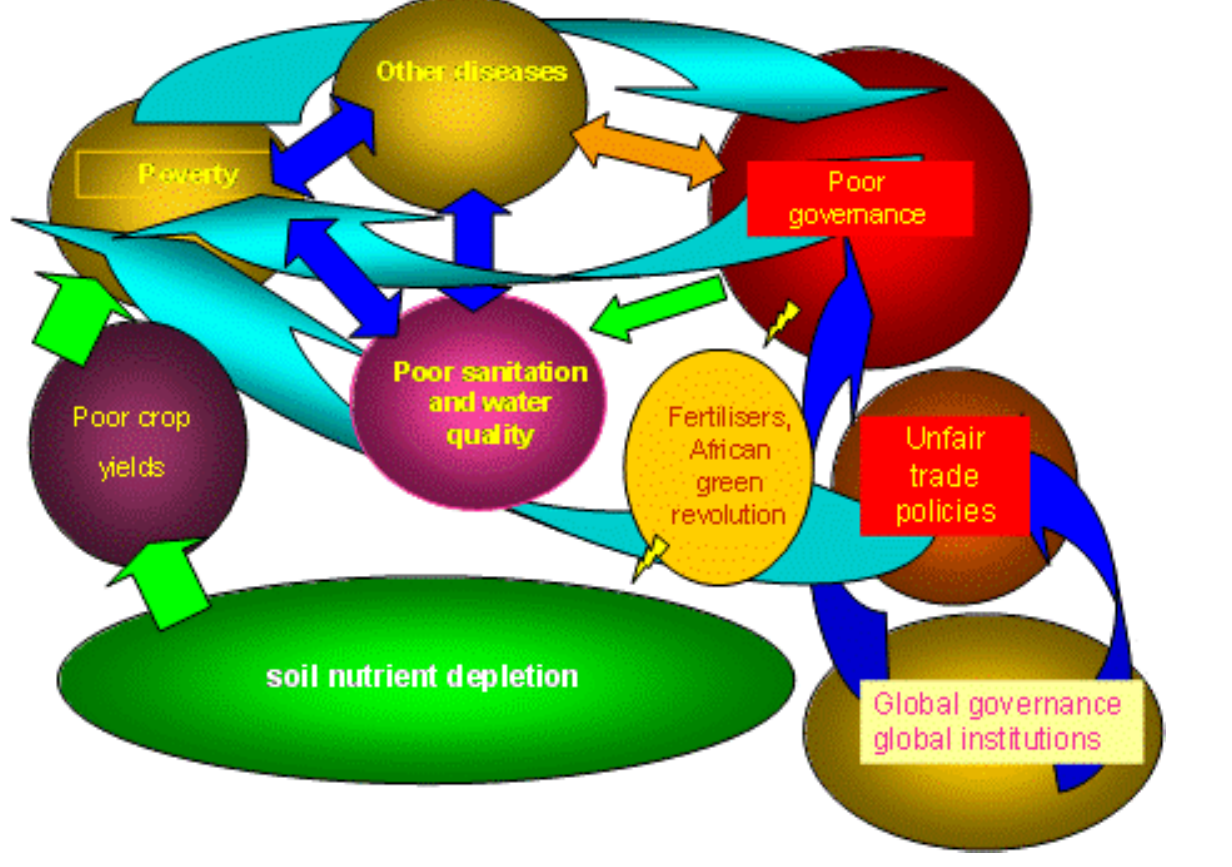
Fig. 1. A complex, interlinked network of factors operate to perpetuate poverty in much of the developing world, including sub-Saharan Africa. Literally dozens of economic, political, and social factors can be identified as contributing to a causal web that effectively serves to lock in poverty, poor governance, and undernutrition. Many of these factors are bi-directional, such as the relationship between poor governance, chronic disease, and poverty. Successful implementation of the Green Revolution appears to be an important factor that could alleviate much of the poverty in sub-Saharan Africa. However, a plethora of factors (some of which are global) inhibit this. The figure attempts to convey the as yet undelivered promise of the Green Revolution as lightning flashes that try, but ultimately fail, to connect (and thus alleviate) governance and soil nutrient